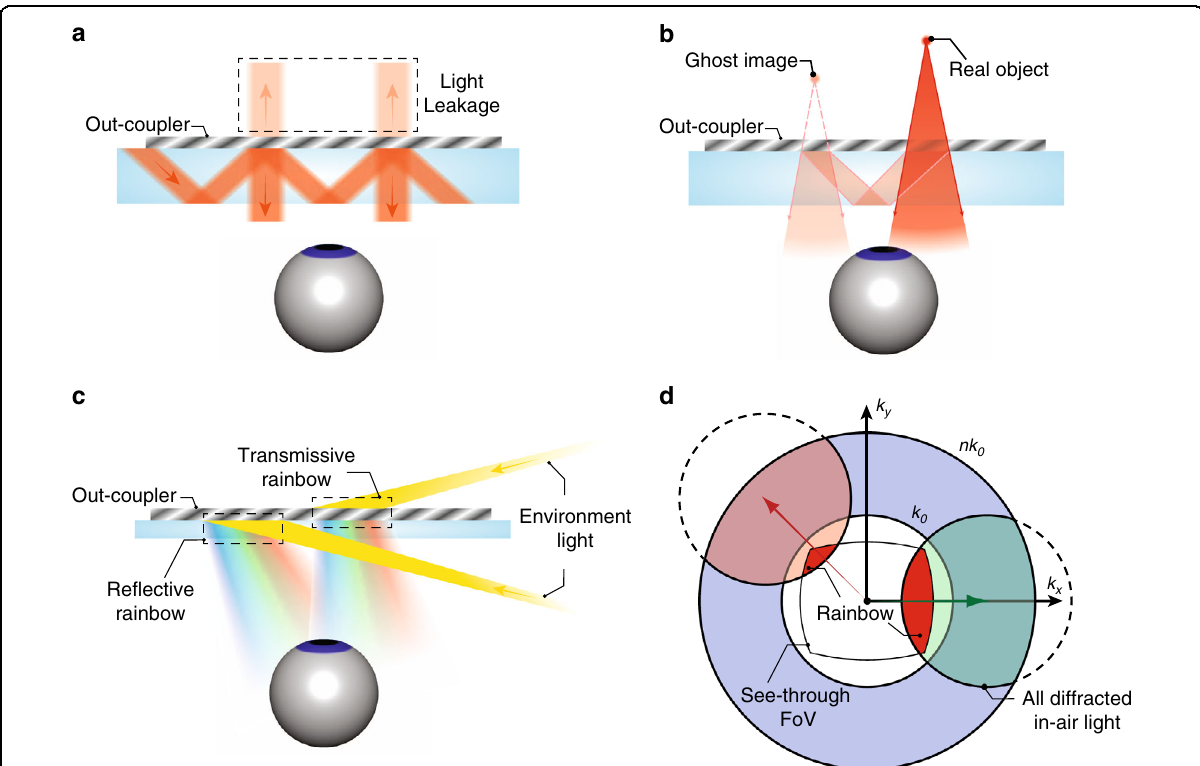
Fig. 14 Artifacts of diffractive waveguide. Sketches of formations of a light leakage, b see-through ghost and c rainbow. d Analysis of rainbow formation with